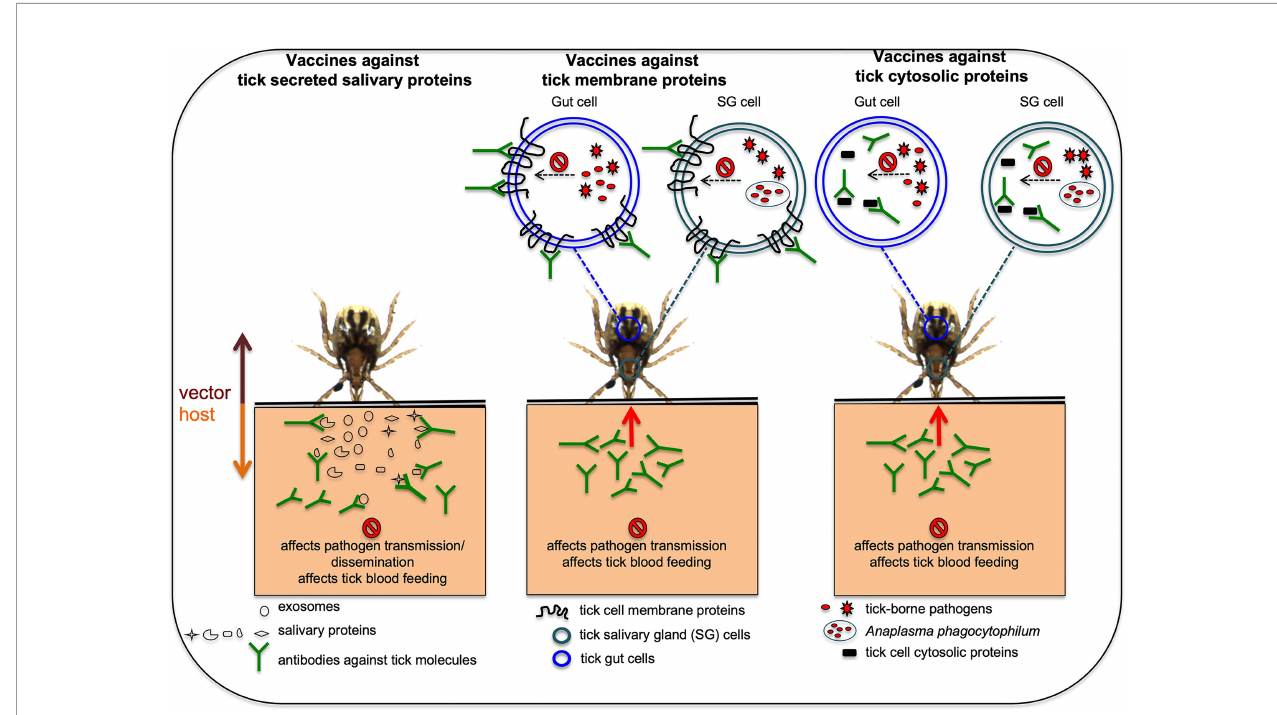
FIGURE 1 | Proposed model on how anti-vector vaccines works against various tick proteins are shown. In hosts that are immunized with antibodies against tick secreted salivary or exosomal proteins that are important in blood feeding or pathogen transmission, the antibodies will bind these tick proteins and could affect pathogen transmission or dissemination and/or affect blood feeding. In hosts that are immunized with antibodies against tick membrane proteins important in blood feeding and/or pathogen transmission, the antibodies enter ticks via a blood meal, binds to the membrane proteins and could affect blood feeding and/or pathogen transmission. In hosts that are immunized with antibodies against tick cytosolic proteins important for blood feeding and/or pathogen transmission, antibodies enter tick body via a blood meal, engulfed inside cells and later binds cytosolic proteins affecting tick blood feeding and/or pathogen transmission. Picture is not drawn to the